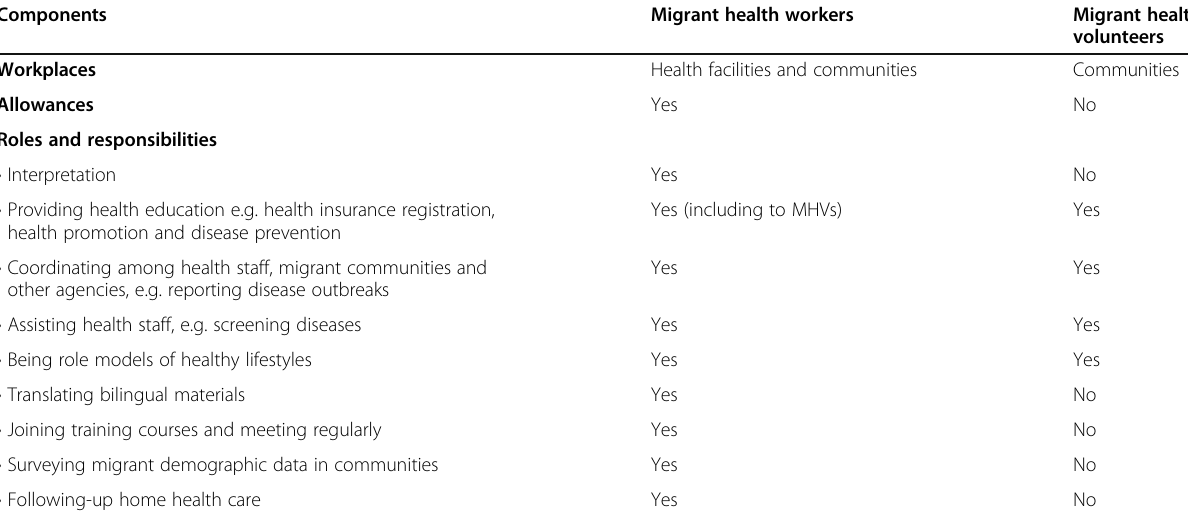
Table 2 Roles and responsibilities of MHWs and MHVs